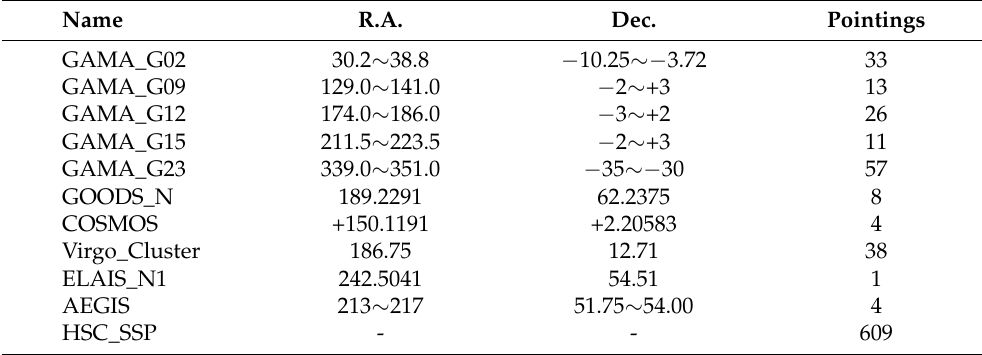
Table 2. Special Sky